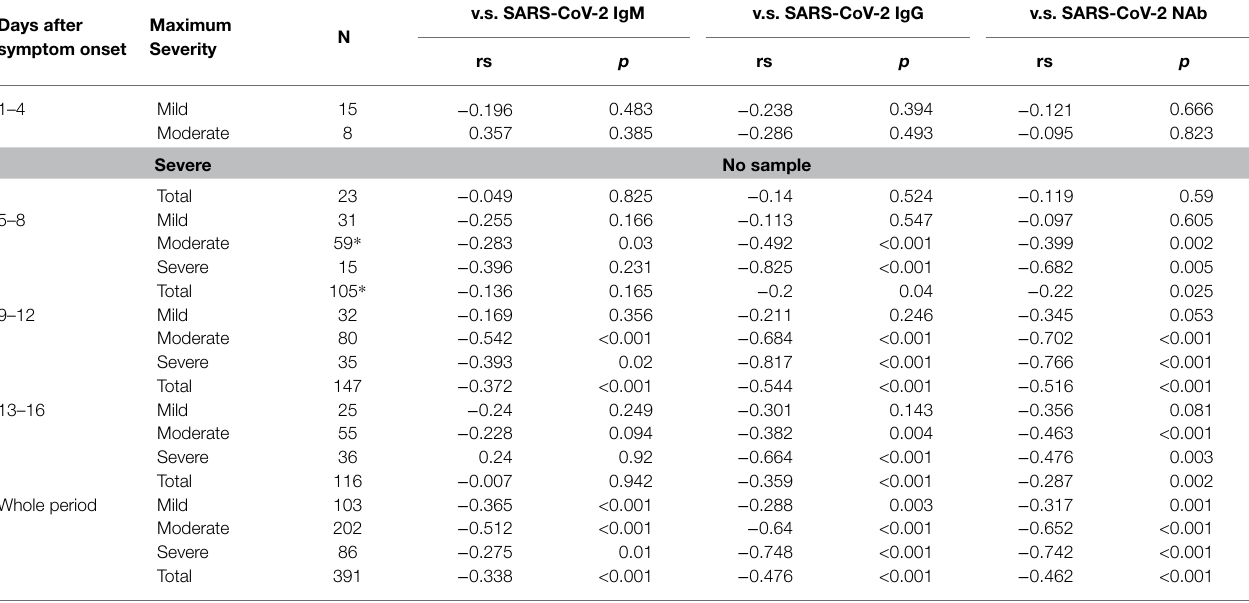
TABLE 2 | Correlation coefficients between the serum N antigen levels and the SARS-CoV-2 IgM/IgG titers. Days after Maximum symptom onset Severity